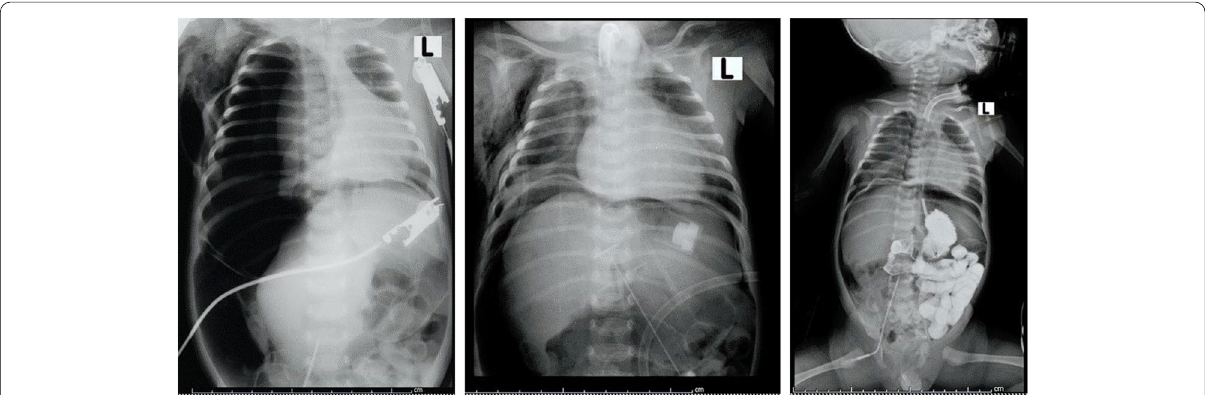
Fig. 3 a CXR; showing right‑sided tension pneumothorax, and pneumoperitoneum. b Follow‑up CXR for Pt in a ; showing resolution of pneumothorax after chest tube insertion and improvement of pneumoperitoneum. c Gastrografin follow‑through; showing no evidence of contrast extravasation from the gastrointestinal